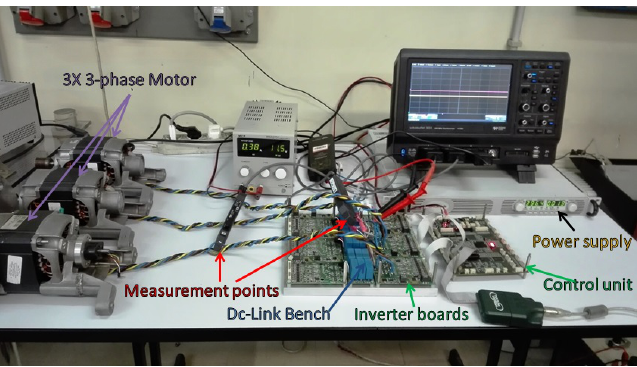
Figure 15. Experimental setup: three 3-phase motors, the control board and the power section with two triple-3-phase